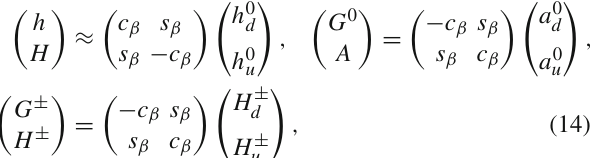
Fig. 6 The decay widths for the b ¯ b channel in the scenario of Fig.4 are shown. Upper left: The predictions of Eq.(13) for the decays of the CP -admixtures H 2 , 3 (dashed green and dotted red) are compared to the widths obtained with a perturbative treatment of the CP -violating mixing (blue and dashed orange). All are almost identical. Lower left: The difference between the predicted decay widths in the perturbative (solid blue) and mixing (dashed orange) description is depicted. Right: